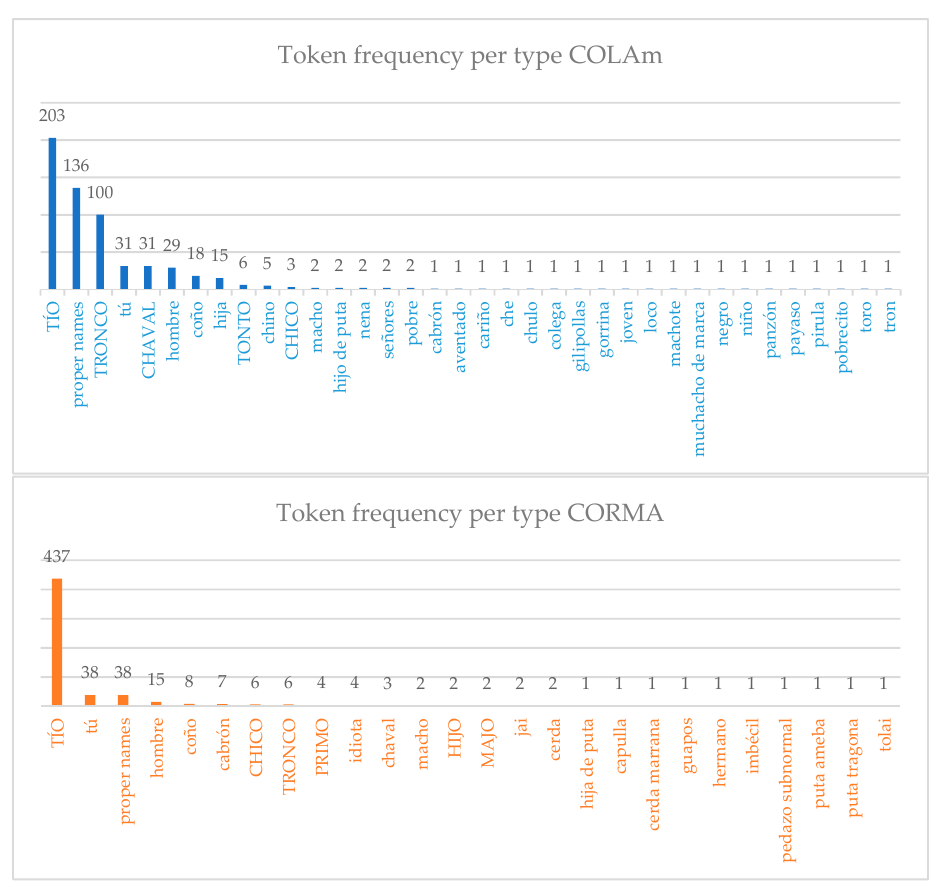
Figure 2. Comparison of the paradigm of vocative types in COLAm and CORMA.